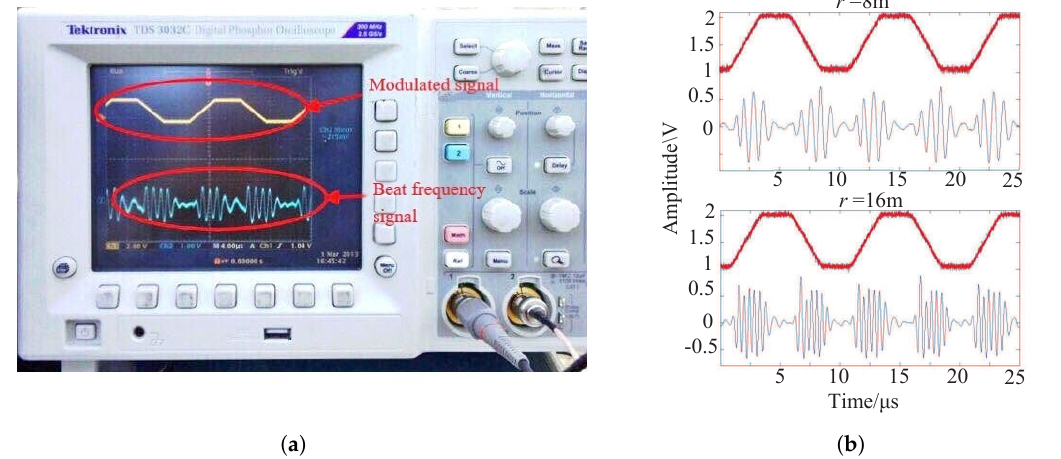
Figure 10. Beat frequency signal captured by the oscilloscope. ( a ) Beat frequency signal. ( b ) Beat frequency signal, r = 8 m, 16